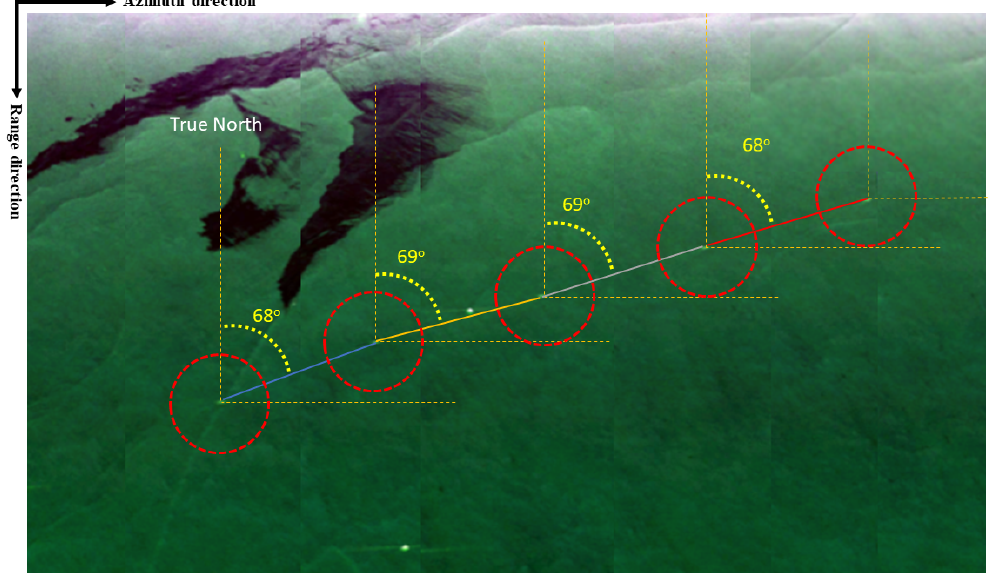
Figure 6. Estimated heading of the fishing trawler annotated on a mosaic composed by the Pauli images excerpted from the whole UAVSAR